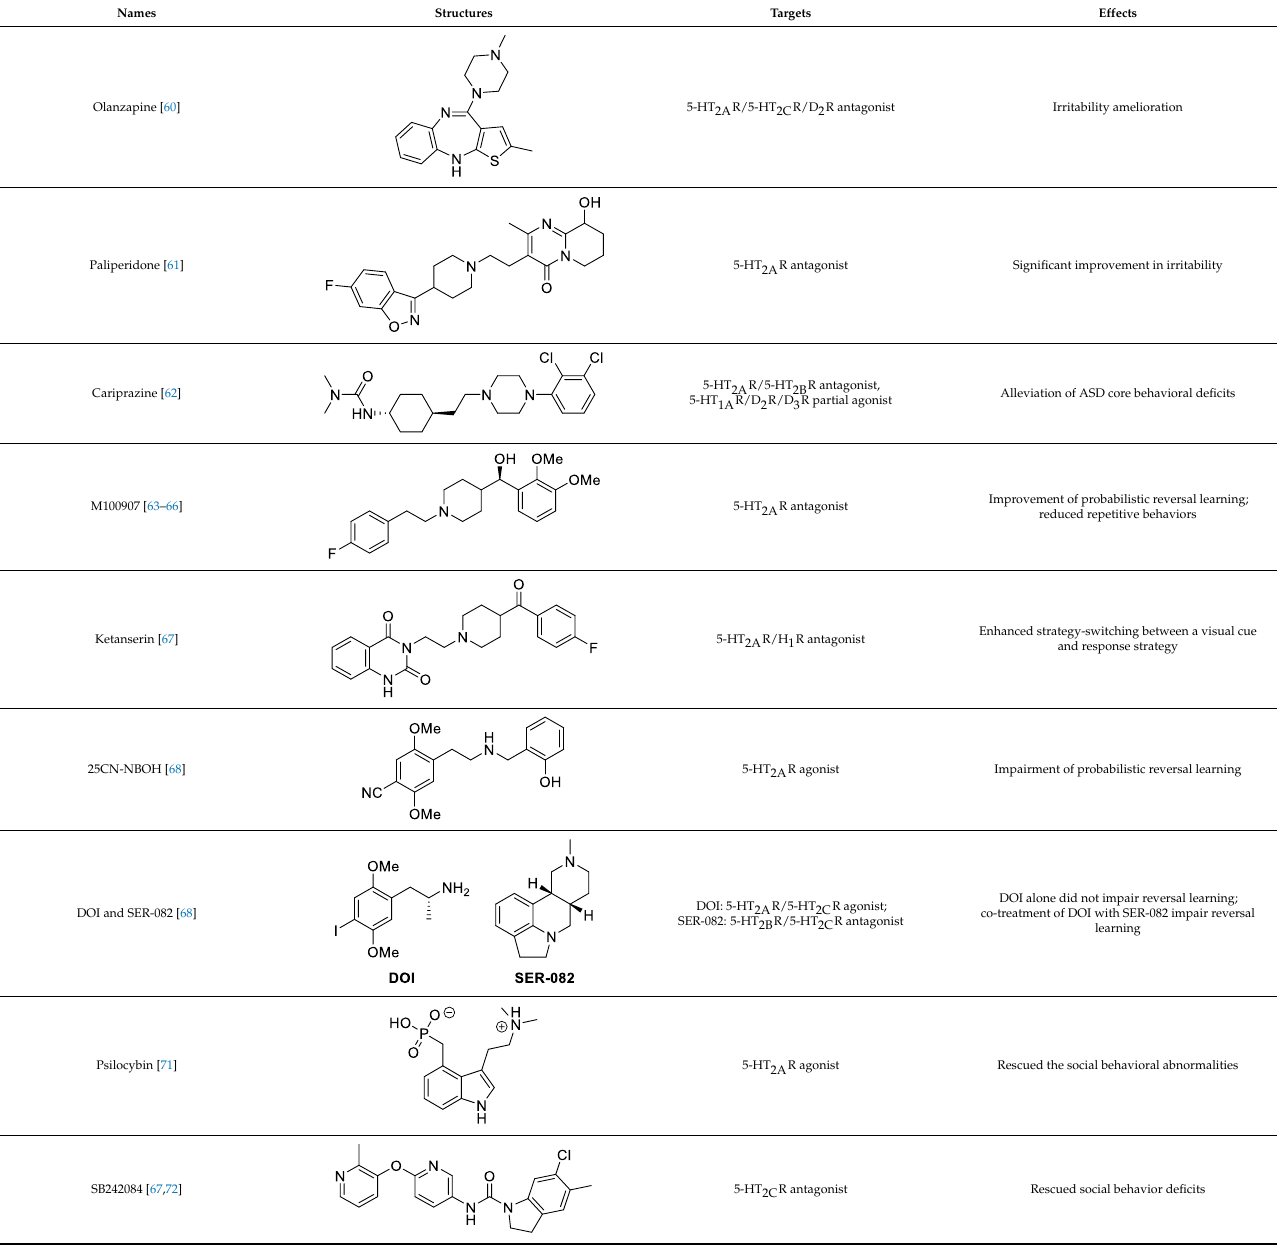
Table 2. 5-HT 2 receptors-targeted pharmacological agents which have potential effects on ASD treatment.